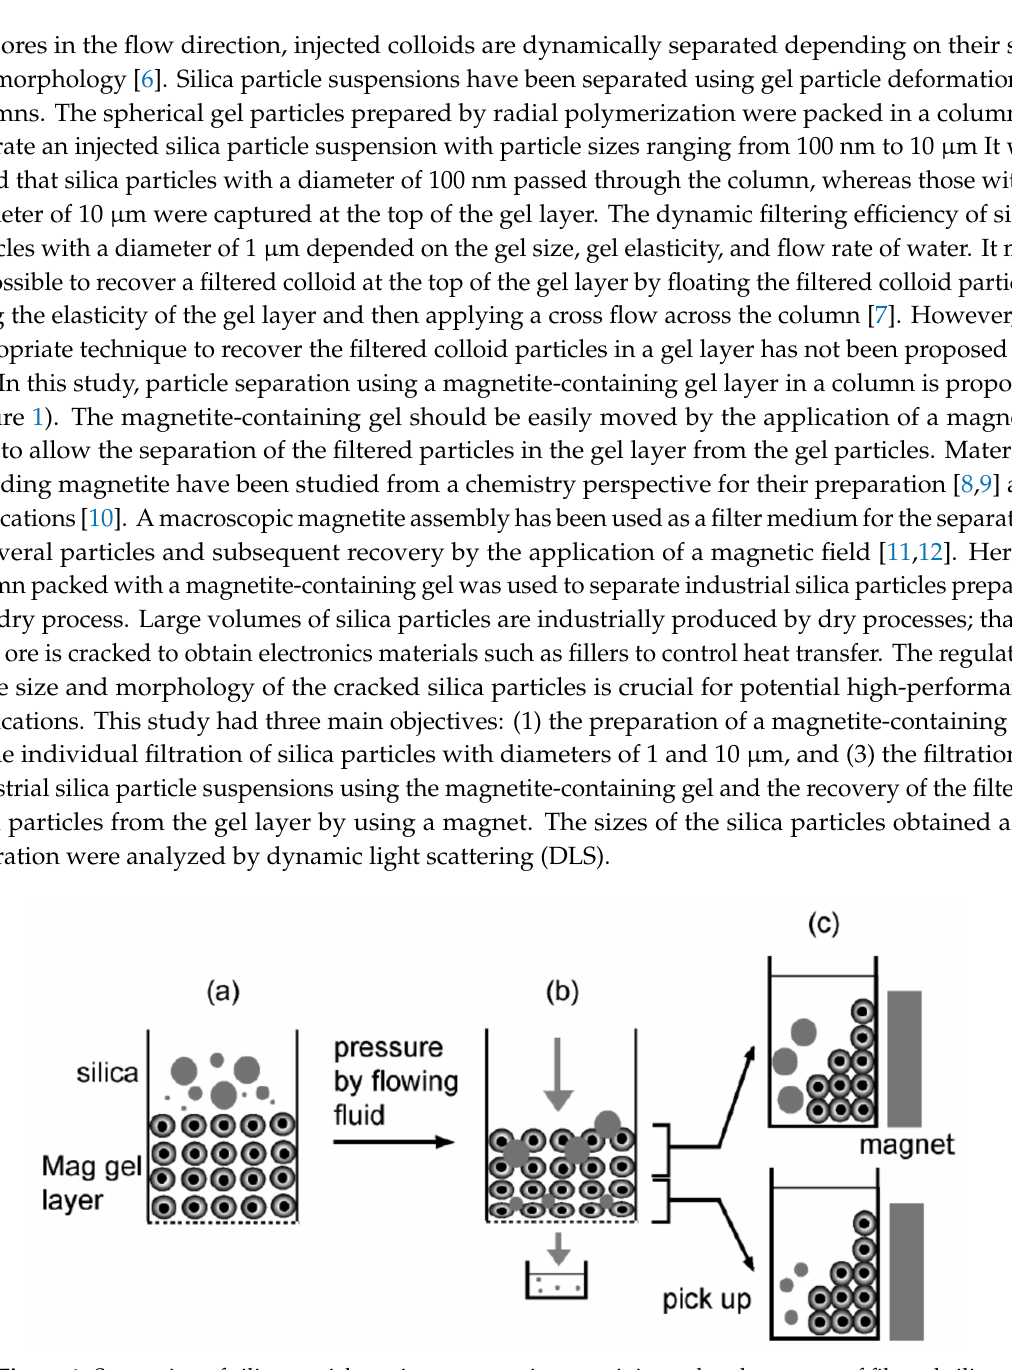
Figure 1. Separation of silica particles using a magnetite-containing gel and recovery of filtered silica particles from the gel by applying a magnet. ( a ) Magnetite-containing gel particles were packed in a column, and then a silica particle suspension was injected on the top of the gel layer. ( b ) The pressure of water flowing through the gel layer induced the deformation of the gel, which changed the filtration pores in the flow direction. As a result, small silica particles were eluted. Larger silica particles remained near the top of the column, and medium silica particles moved closer to the bottom of the column. ( c ) The magnetite-containing gel and filtered silica particles were taken from each region of the column, and then a magnet was applied. The magnetite-containing gel moved towards the magnet, allowing the filtered silica particles and magnetite-containing gel to be